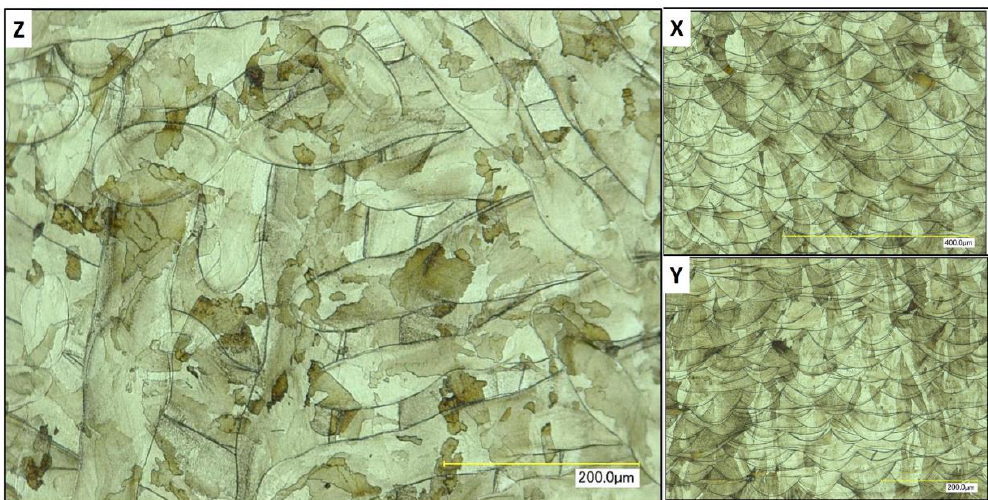
Figure 13. Illustration of micro-sections of cube printed with Powder A. All scale bars are 200 μm. X, Y and Z refer to the faces of the cube in relation to the melt pool (Z).